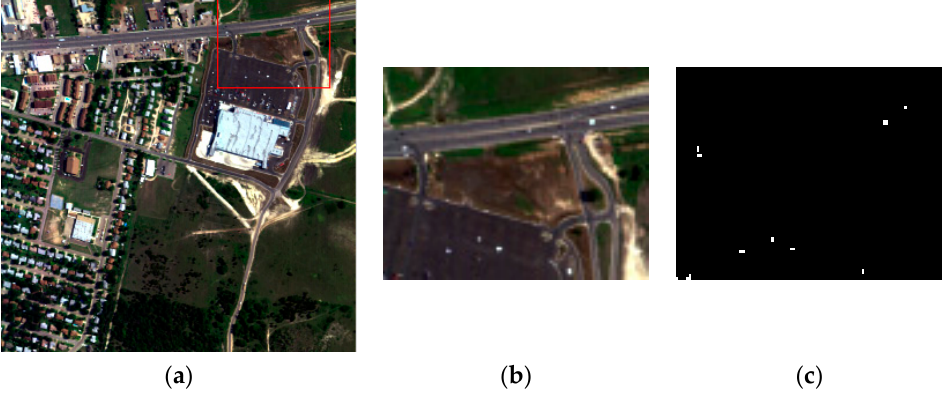
Figure 5. HYDICE_Urban dataset: ( a ) false-color image of the whole scene; ( b ) false-color image of the detection area; ( c ) the ground-truth map.